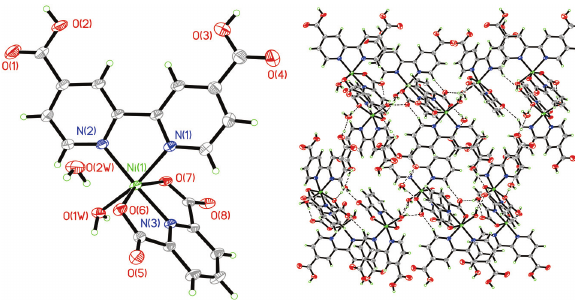
Table 1: Data collection and handling.